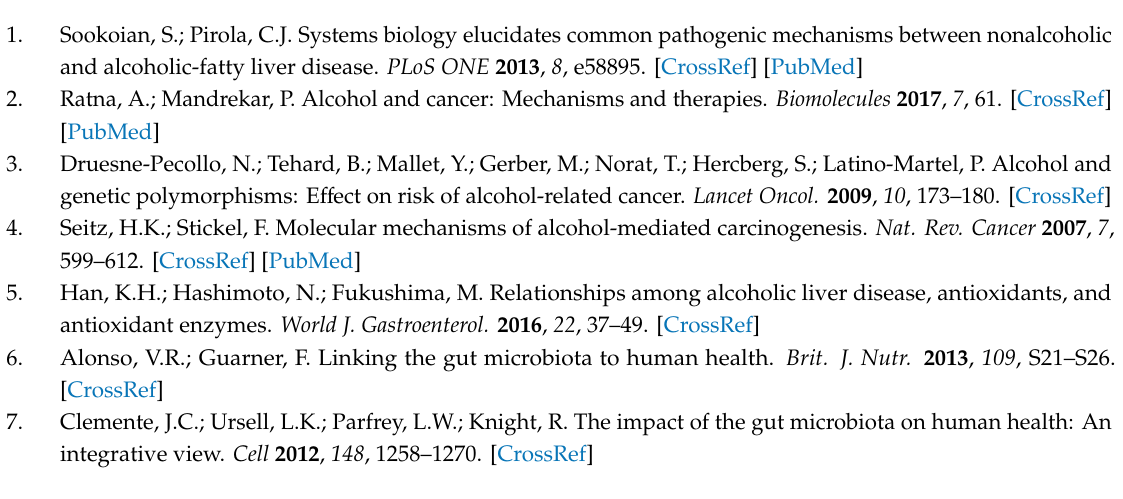
Figure S1: Animal experiment design, Table S1: Total polyphenol and total flavonoid contents of Dendropanax morbifer leaf and stem extracts, Table S2: Antioxidant activity of the Dendropanax morbifer leaf and stem extracts, Figure S2: HPLC chromatogram of Dendropanax morbifer leaf and stem extracts, Table S3: Body weight change and liver-body weight ratio of Dendropanax morbifer leaf ethanol and D.W extracts in alcohol-fed rats, Figure S3: Comparison of microbiota according to the concentrations of DML extracts. Numbers indicate the concentrations of DML treatments, Figure S4: Comparison of microbiota before DML extract treatment, Table S4: Analysis of molecular variances (AMOVA), Figure S5: Comparison of the taxonomic